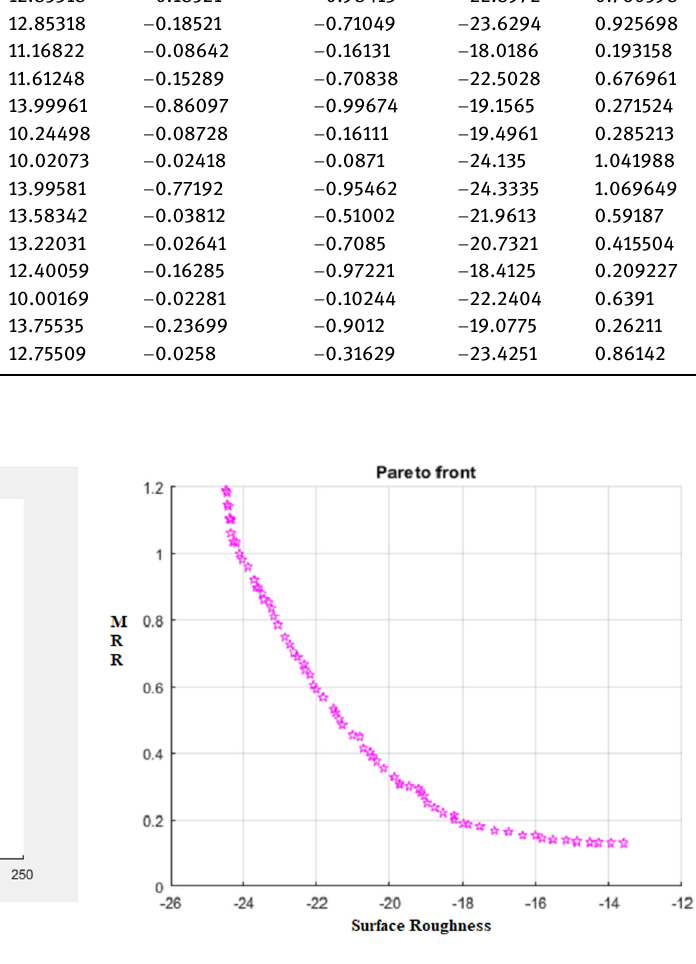
Figure 15: Pareto optimal solution of NSGA - II.